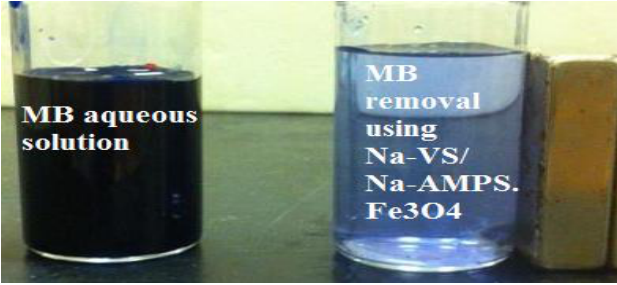
Figure 6. Photo of MB removal from water using VS/AMPS·Fe 3 O 4 adsorbent by an external magnet.